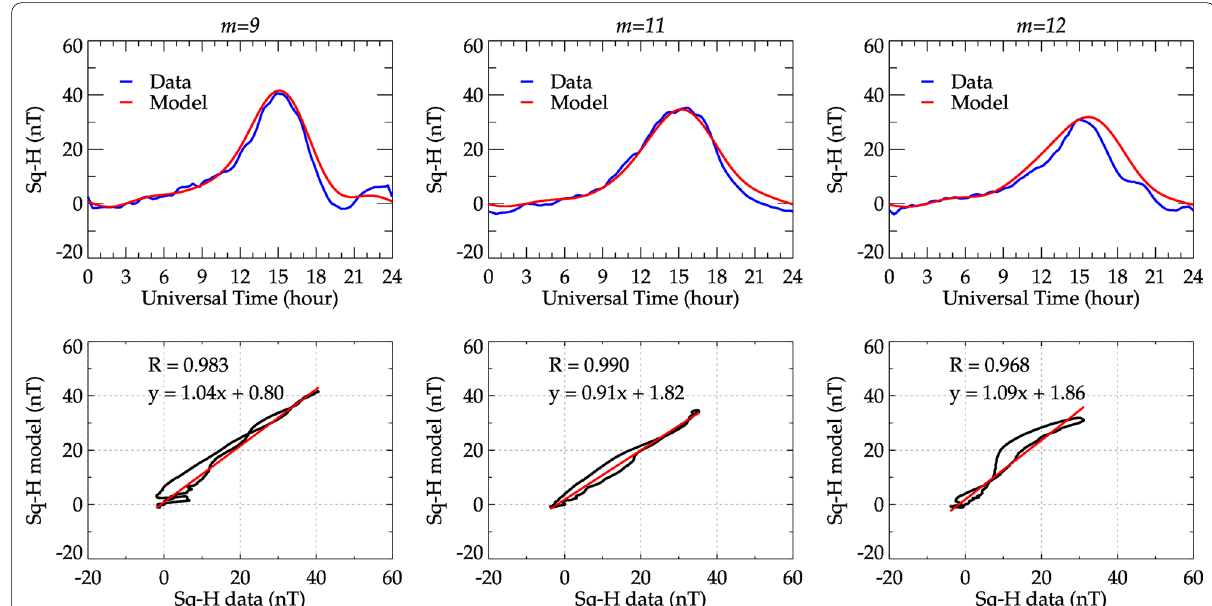
Fig. 3 Top panels correspond to the monthly Sq-H field obtained for MED using the interpolated parameters of the SQRF model (red) and the magnetic field data (blue) in September ( m dispersion plots of the Sq-H field for each of the presented